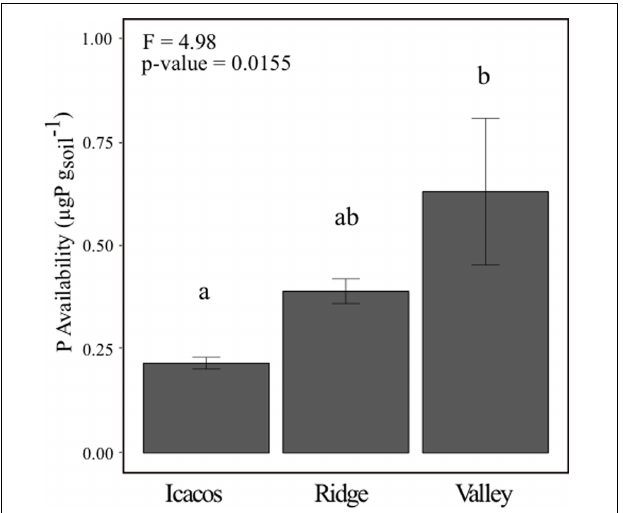
FIGURE 1 | Soil resin P availability across all three sites with letters denoting similarity/dissimilarity of group means. Error bars represent mean ± SE with n = 10 (Icacos), n = 9 (Ridge), and n = 9